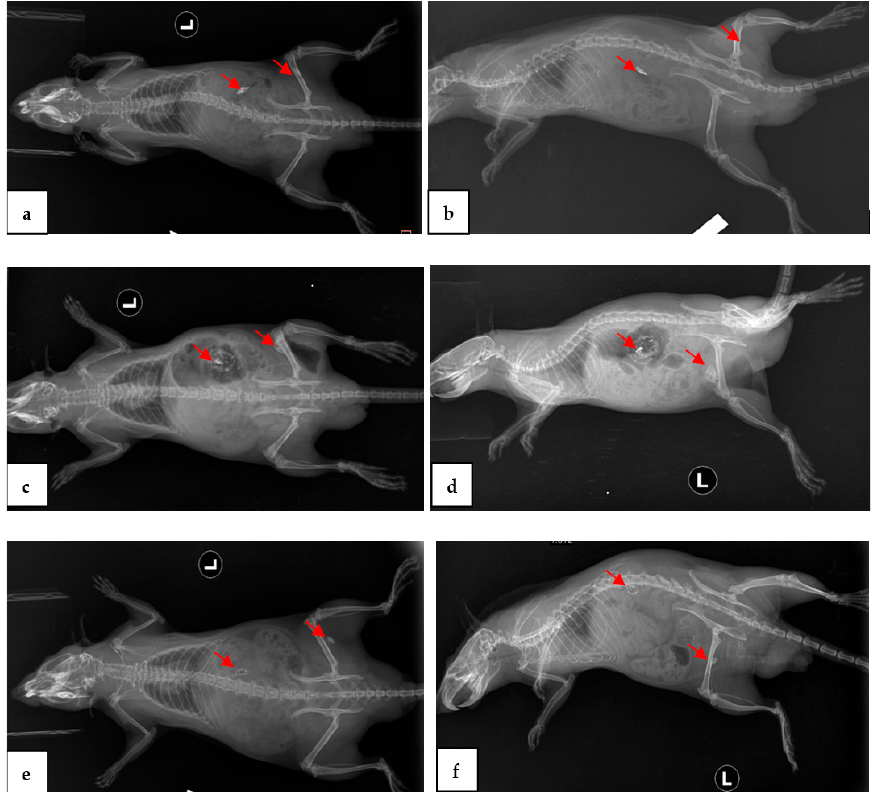
Figure 2. Rats, post-operative representative radiographs, Mg-0.5Ca-xY alloy (red arrows) and air sacs, dorsal–ventral ( a , c , e ) and lateral–lateral ( b , d , f ) lying. After 2 weeks ( a , b ), 4 weeks ( c , d ), and 8 weeks ( e , f ).